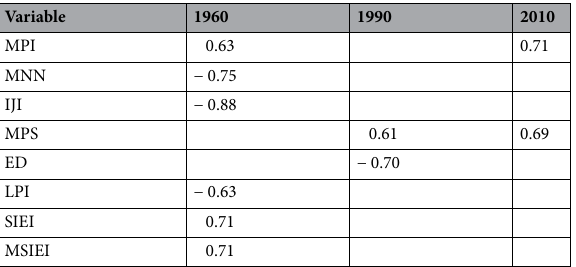
Selected landscape metrics were reported at the regional scale using descriptive statistics. Pair-wise relationships between each metric and the ESAI average value were analysed at the regional scale using Spearman non-para- metric rank coefficients testing for significance at p < 0.05 after Bonferroni’s correction for multiple comparisons 53 .